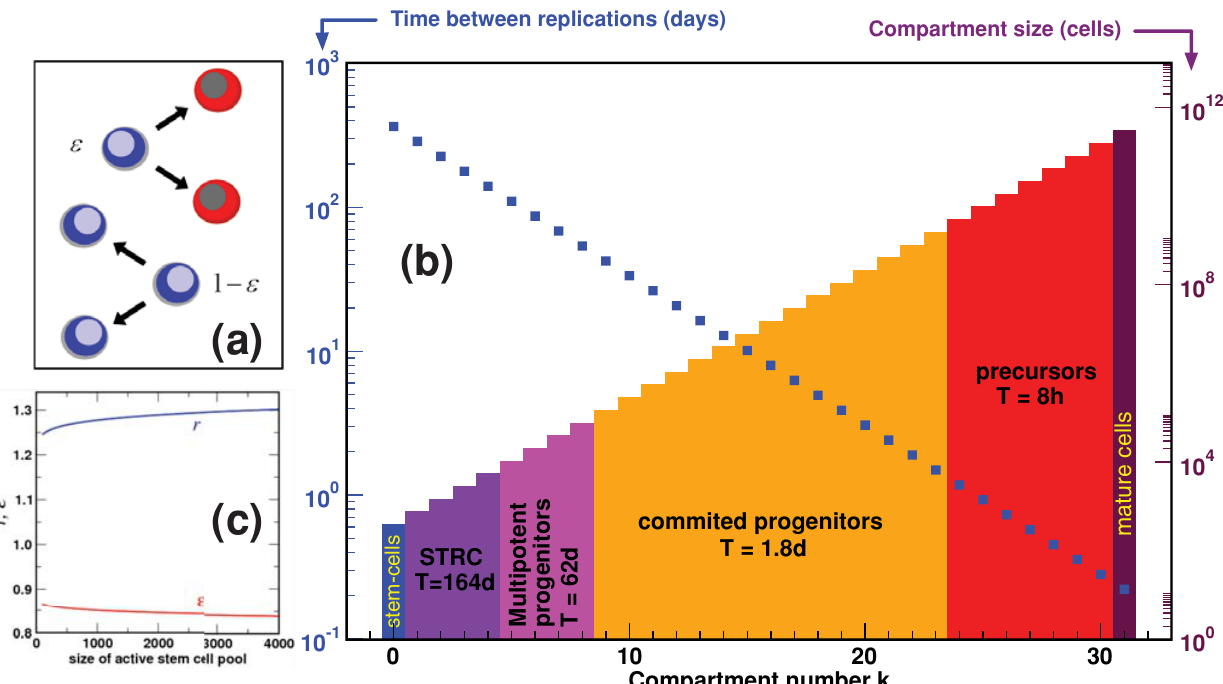
Figure 1. a) During mitosis, the parent cell may give rise to daughter cells that are different from the parent ( probability e ) being transferred downstream or, with probability 1 2 e , to daughter cells identical to the parent which contribute to repopulate their own compartment. b) Hematopoiesis is maintained by a small group of stem cells that replicate slowly; subsequent steps lead to cell amplification and accelerated replication so that the populations grow exponentially. Contributions of each identified group of cells to hematopoiesis were computed as the weighted average based on the population distribution, being very similar to published estimates (STRC stands for short term repopulating cell, d is time in days and h is time in hours). c) The model parameters r , e are robust to changes in the size of the active stem cell